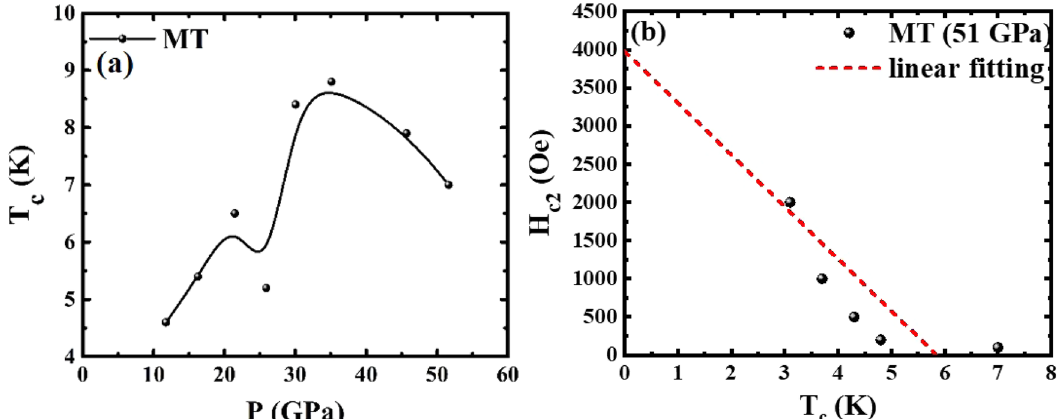
Fig. 3 The T c evolution on pressure and the phase boundary in the H – T plane. a T c vs. P from MT results. For MT measurement, T c is determined from by d M /d T vs. T as described in Supplementary Fig. 6-1. b The magnetic fi eld dependence of T c for MT at 51